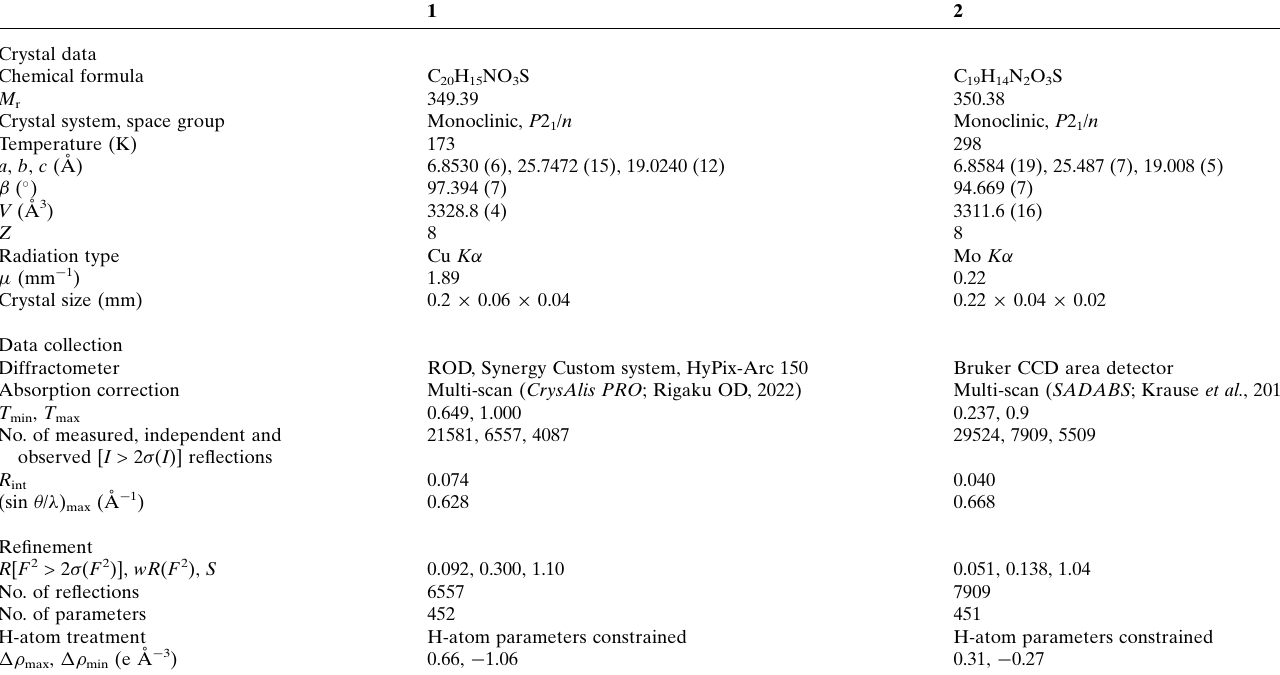
Crystal data Chemical